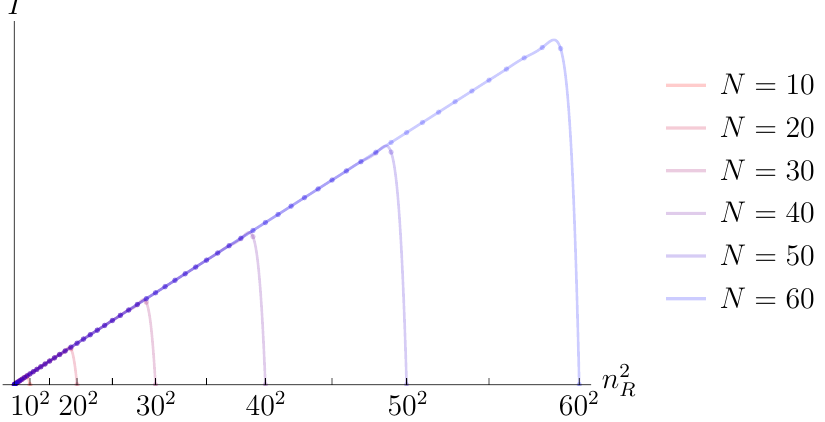
Figure 5 . The mutual information as function of n for (cid:22) = 1 =a , T = 1 = 2 a and various values of N